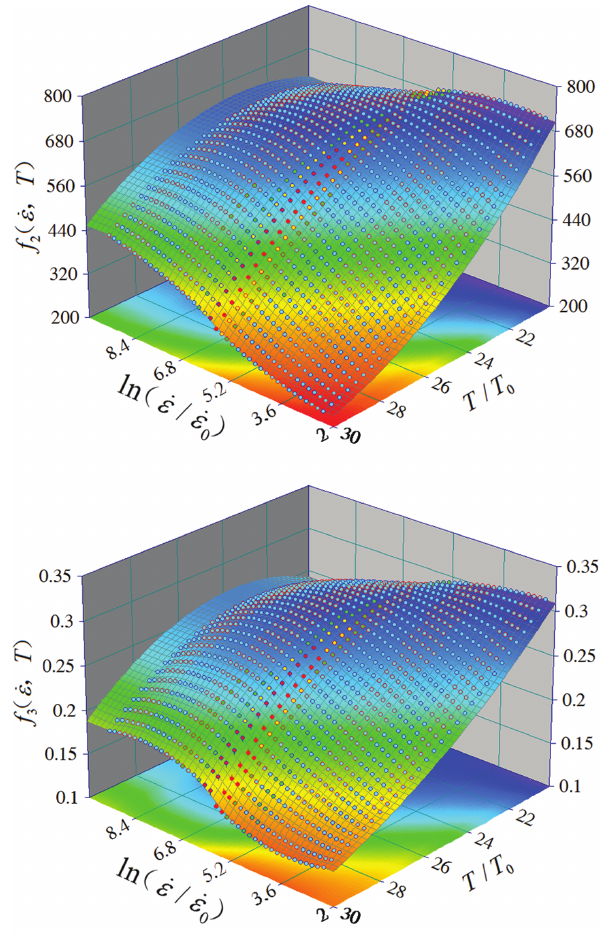
Figure 12: Fitting results of f 2 ð _ ε , T Þ and f 3 ð _ ε , T Þ at medium temperature region.